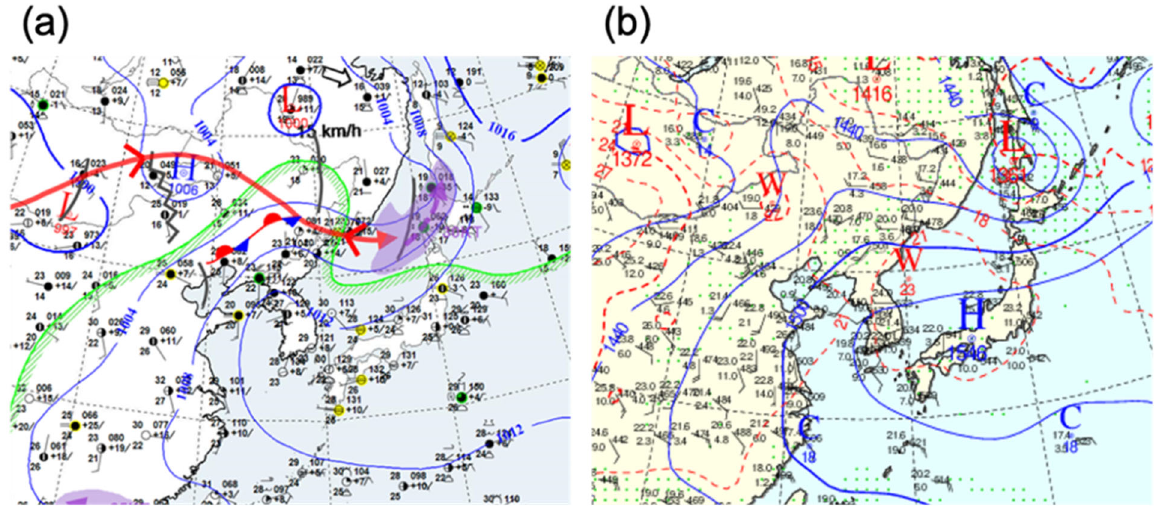
Figure 2. Weather chart of ( a ) surface and ( b ) 850 hPa at 09:00 LST, 15 July 2018, issued by the Korea Meteorological Administration.